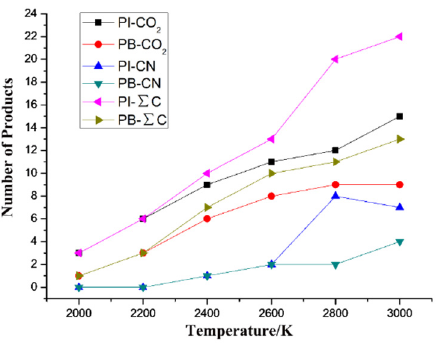
Figure 8. Product formation of the PI neat and PI/BNNS systems at different temperatures.